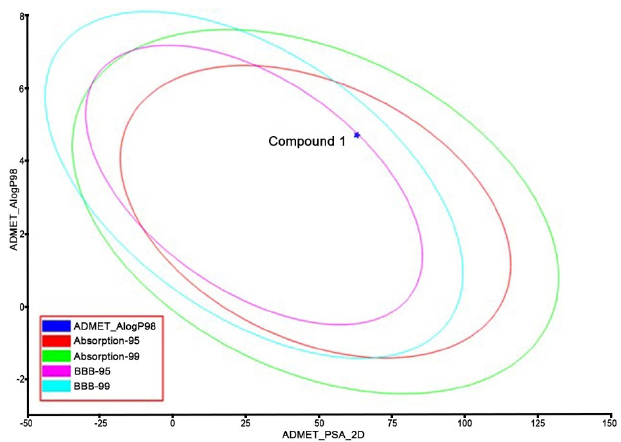
Figure 9. Pharmacokinetic analysis of Compound 1 (TOPKAT). Table 2. Pharmacokinetic analysis for Compound 1 (TOPKAT).